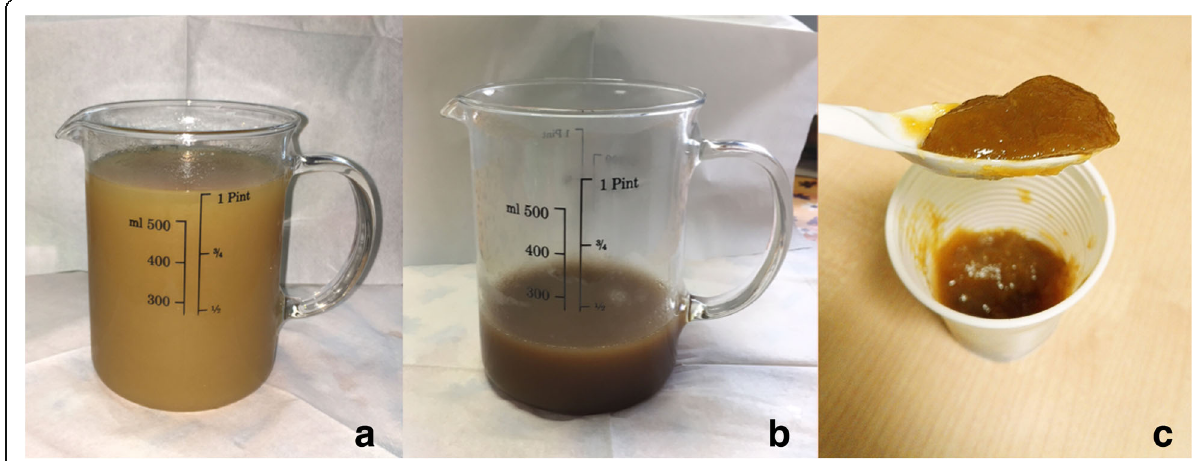
Fig. 1 a Pineapple juice before the microwave heating evaporation process. b Concentrated pineapple juice after the microwave heating evaporation process. c The solution after the addition of modified potato